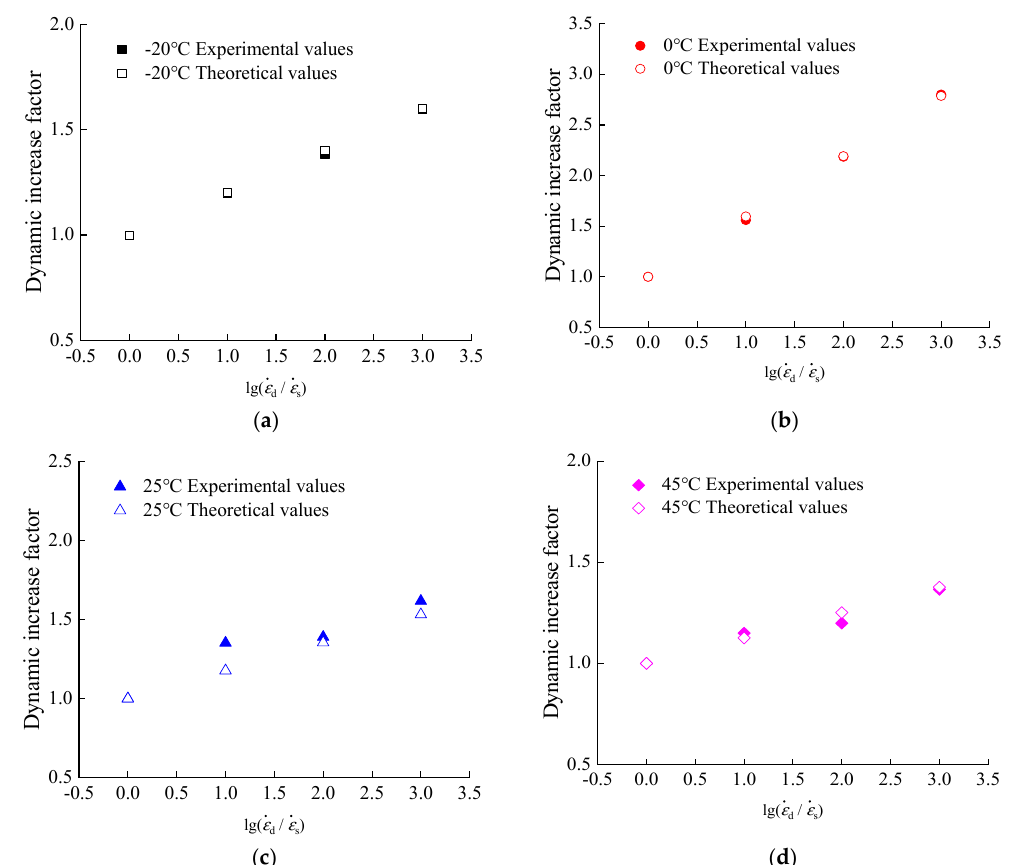
Figure 13. Relation between strain rate effect parameters and temperature.